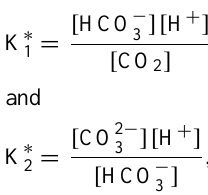
], (cid:127) CaCO , 3 3